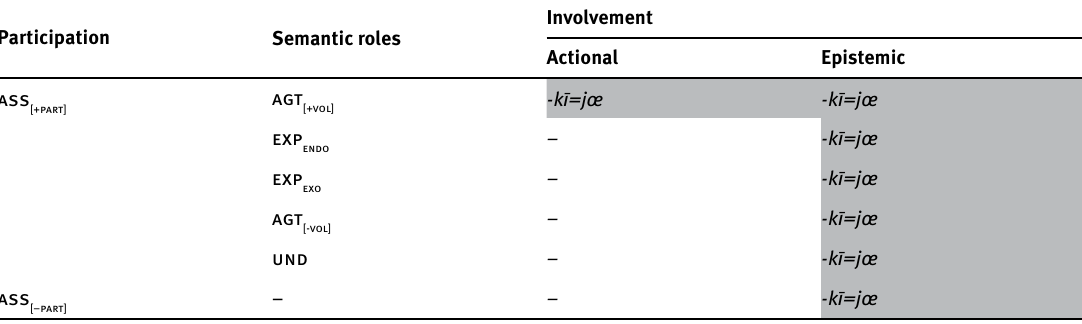
Figure 4. Modeling Shigatse Tibetan imperfective egophoricity